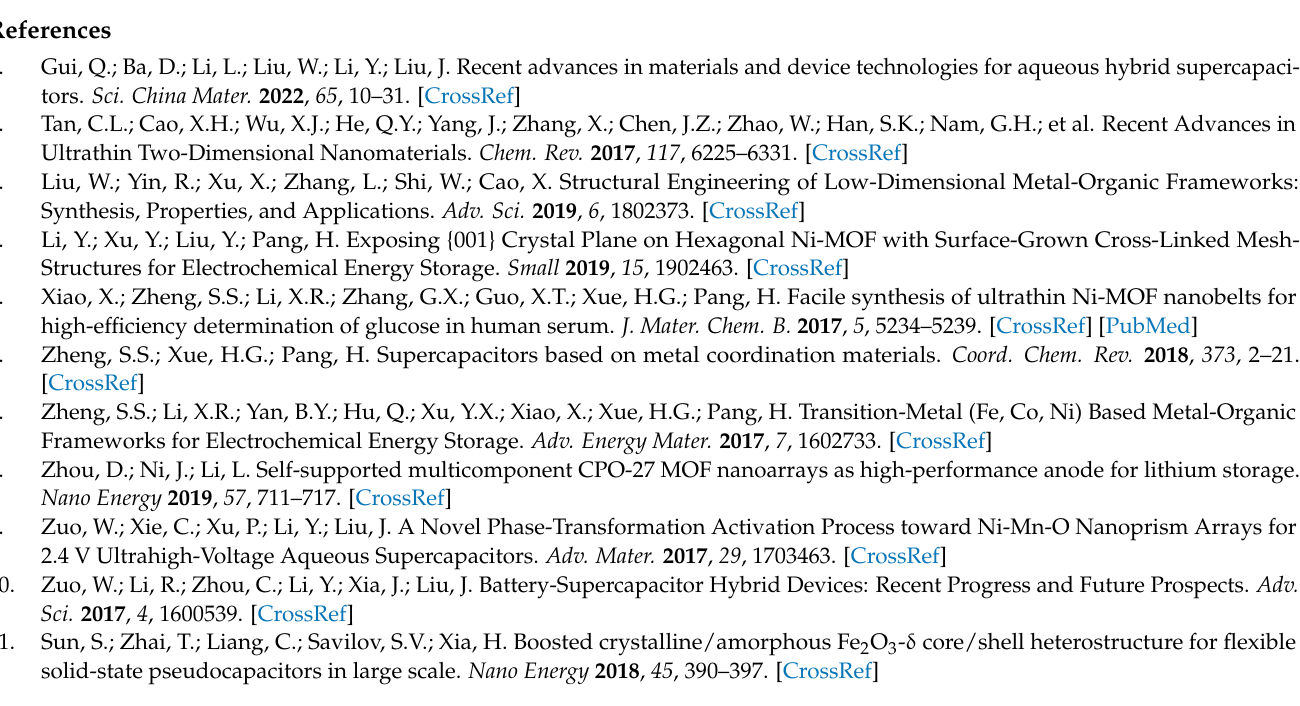
Figure S3: C 1s spectra of Ni-MOF-60, Ni-MOF-80, Ni-MOF-100, and Ni-MOF-120; Figure S4: N 1s spectra of Ni-MOF-60, Ni-MOF-80, Ni-MOF-100, and Ni-MOF-120; Figure S5: O 1s spectra of Ni-MOF- 60, Ni-MOF-80, Ni-MOF-100, and Ni-MOF-120; Figure S6: BET curves and the pore size distribution curves of a series of Ni-MOF, ( a ) Ni-MOF-60, ( b ) Ni-MOF-80, ( c ) Ni-MOF-100, and ( d ) Ni-MOF-120; Figure S7: CV curves of a series of Ni-MOF in three-electrode system, ( a ) Ni-MOF-60, ( b ) Ni-MOF-80, ( c ) Ni-MOF-100, and ( d ) Ni-MOF-120; Figure S8: GCD curves of a series of Ni-MOF in three-electrode system, ( a ) Ni-MOF-60, ( b ) Ni-MOF-80, ( c ) Ni-MOF-100, and ( d ) Ni-MOF-120; Figure S9: Comparative EIS images of Ni-MOF-60, Ni-MOF-80, Ni-MOF-100, and Ni-MOF-120; Table S1: BET surface of Ni-MOF-60, Ni-MOF-80, Ni-MOF-100, and Ni-MOF-120,; Table S2: Various MOF materials